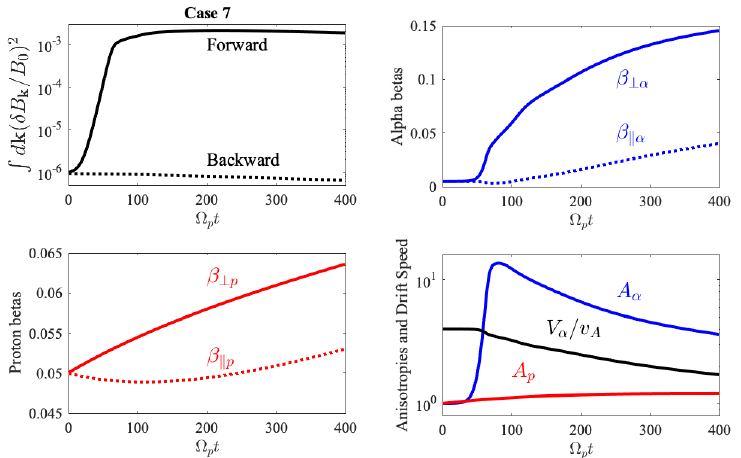
Figure 5. Case 7: QL dynamical evolution of the magnetic wave energy density ( top left panel ), plasma beta parameters for protons ( bottom left panel ), and alpha particles ( top right panel ), and for relaxing the drift velocity and inducing temperature anisotropies ( bottom right panel ). See text for